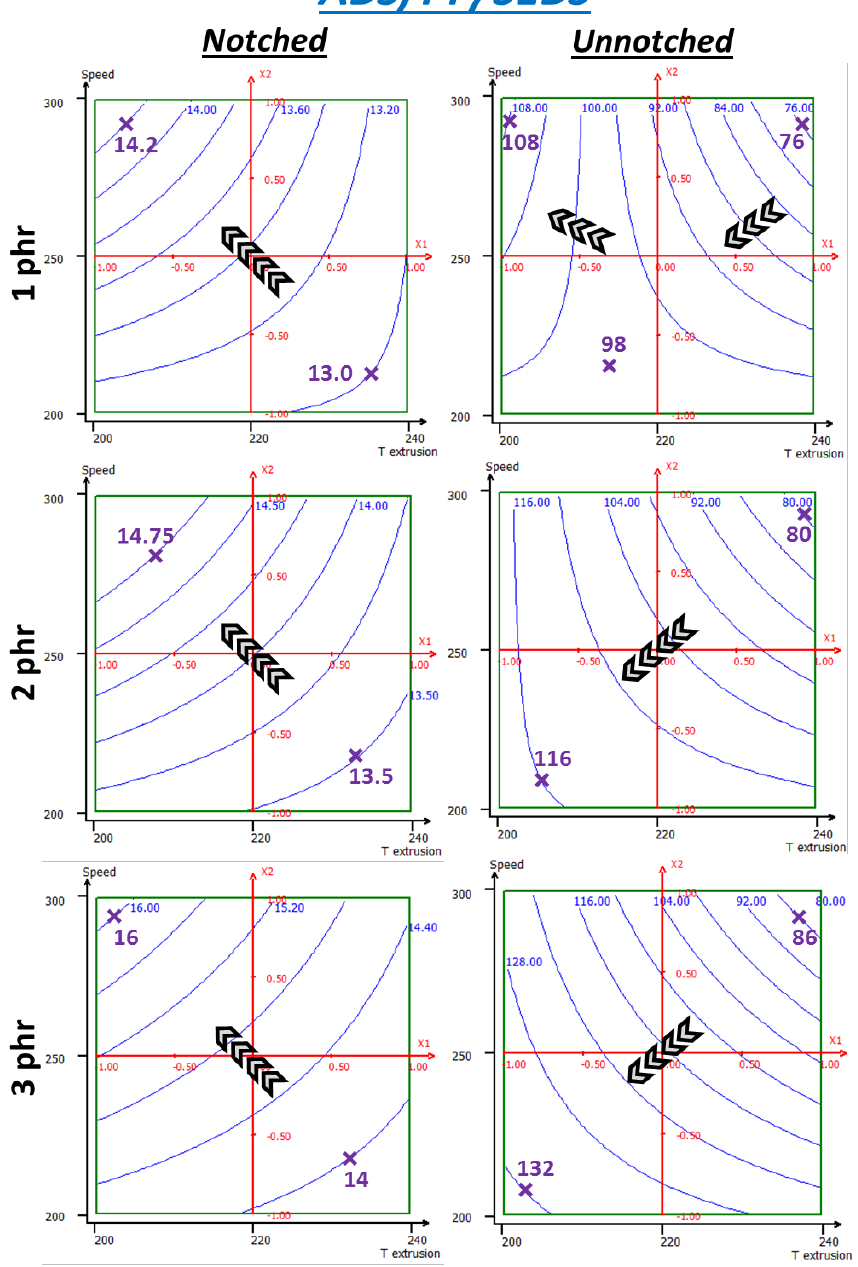
Figure 18. RSM applied to notched and unnotched Charpy break energies (kJ/m 2 ) of ABS + 4 wt% PP + SEBS—same variables as those used